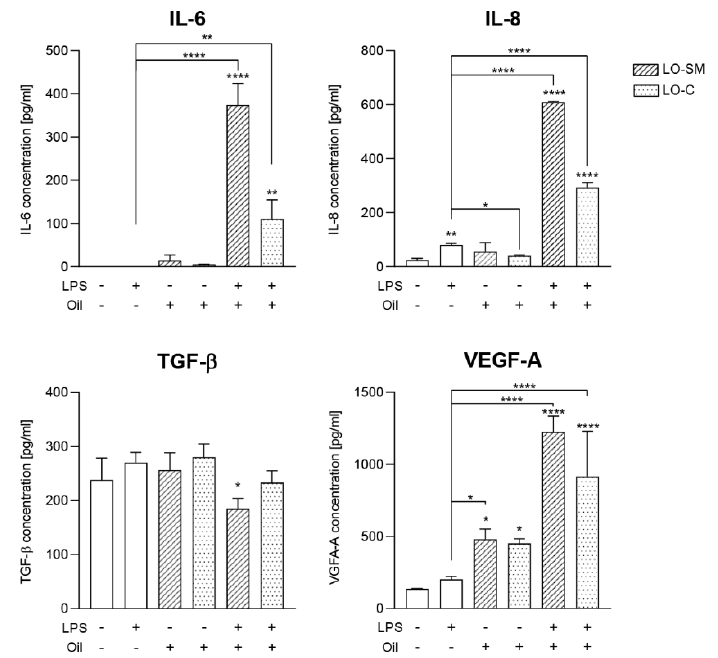
Figure 8. Effect of co-stimulation with lavender oil and bacterial LPS on the cytokines production in HaCaT cell line. HaCaT cells were stimulated with 0.01% of commercial or in-house preparation of lavender oil and 5 ug/mL of Escherichia coli LPS for 24 h. Level of cytokine in cell media: IL-6, IL-8, TGF- β , and VEGFA were verified with ELISA. Values are mean ± SD. Groups were compared to the control, and statistical analysis was performed using GraphPad Prism and build-in ANOVA test. Individual comparisons between groups are indicated by the gates. p -values ≤ 0.05 were considered significant. *— p = 0.05–0.011; **— p ≤ 0.01; ****— p ≤ 0.0001.